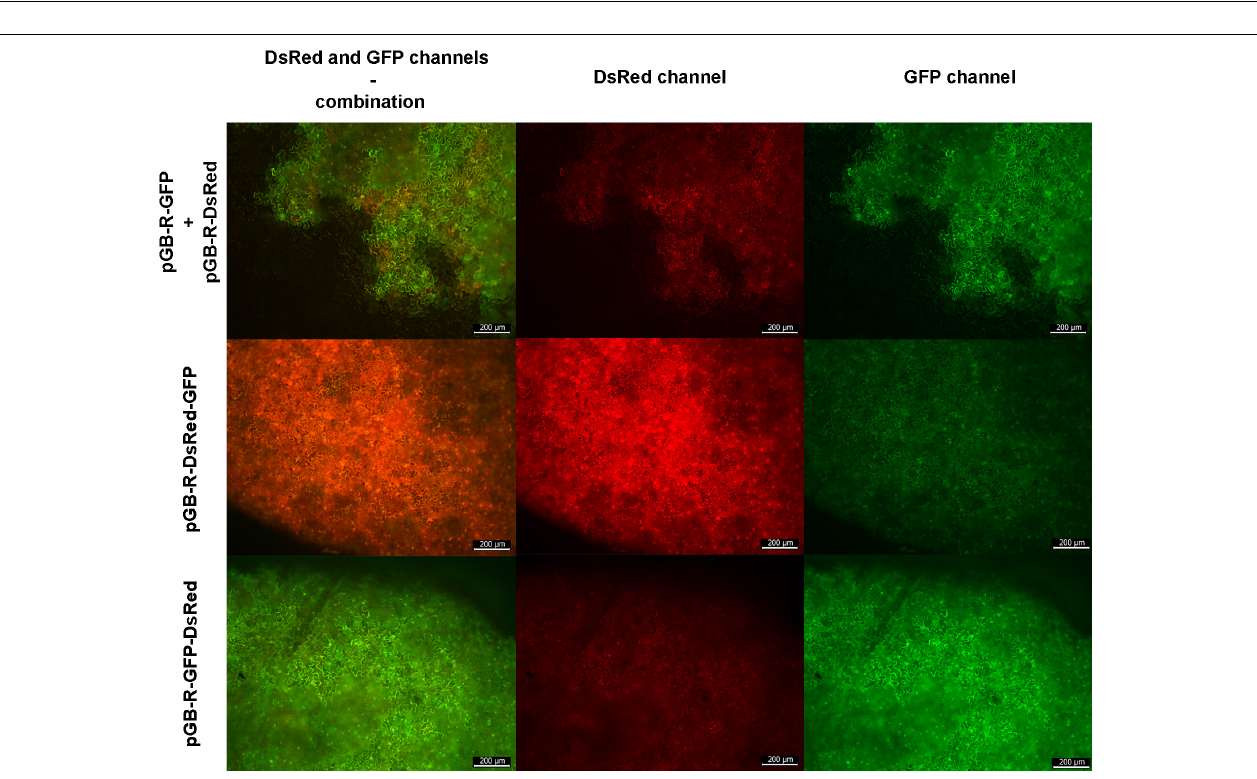
FIGURE 6 | Composite microscope image showing the fluorescence of the replicating constructs 5 DPI. The composite images from both red and green channels are in the left column, DsRed channel in the middle and GFP channel on the right. Top row shows the signal from two independent agrobacteria and plasmids, middle and bottom row are replicating constructs with two TUs (pGB-R-DsRed-GFP and pGB-R-GFP-DsRed, respectively). The scale bar shows 200 µ m.